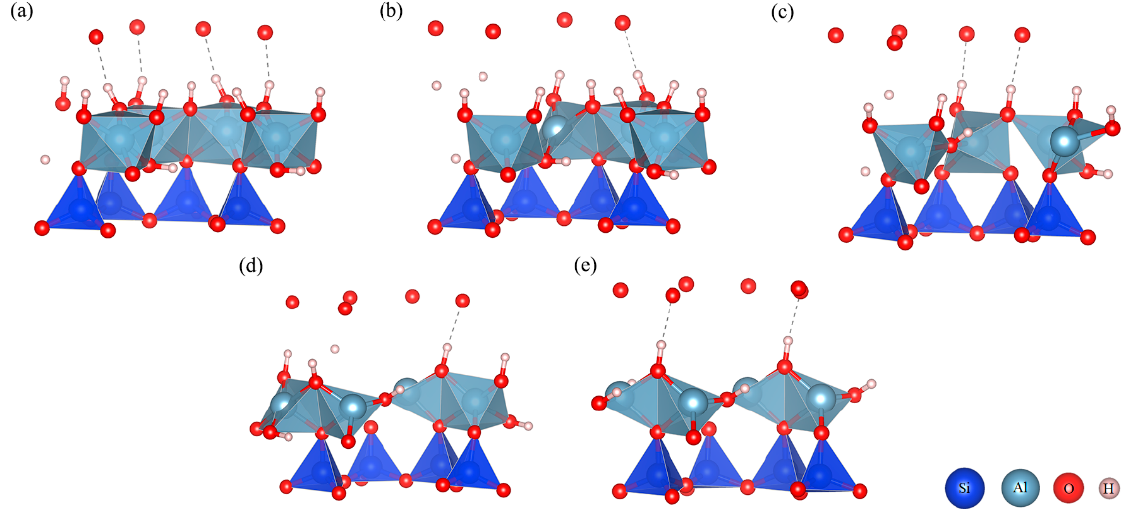
Figure 4. Crystal structure of ( a ) Sim-Ka, ( b ) Phase 1, ( c ) Phase 2, ( d ) Phase 3 and ( e ) Phase 4.